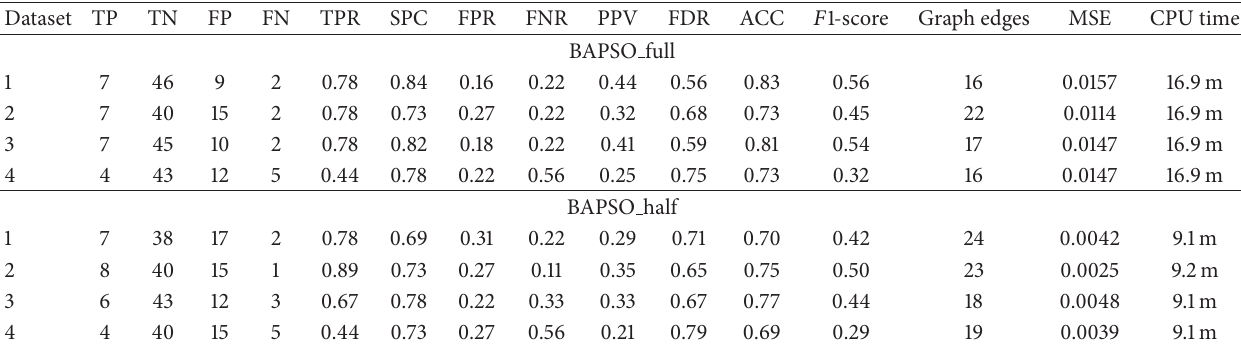
Table 2: Results of the E. coli experiments with all the available time points.